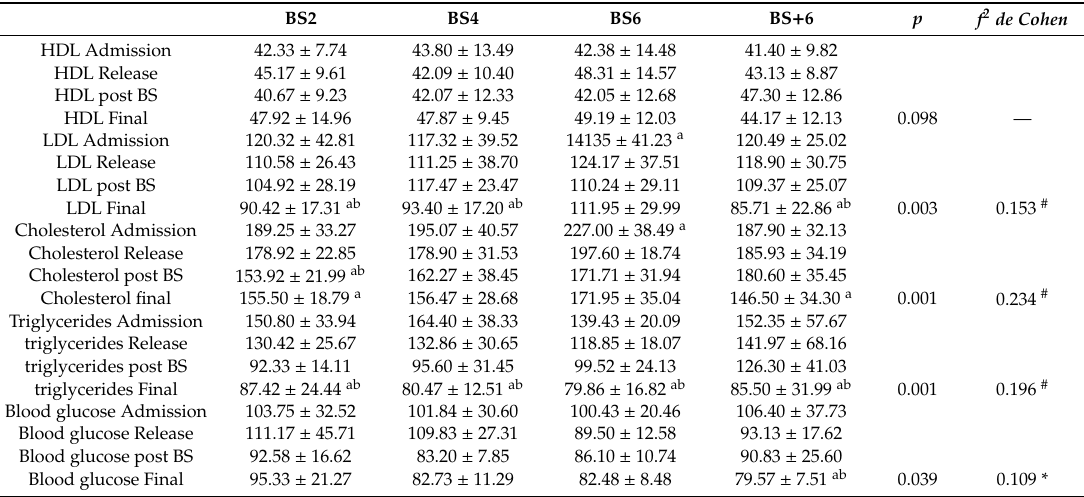
Table 4. Biochemical marker levels in the